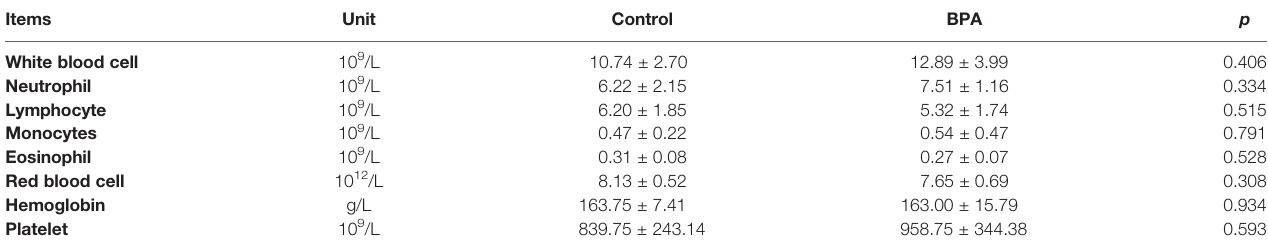
TABLE 3 | Effect of BPA on the blood cell counts in rats. Items